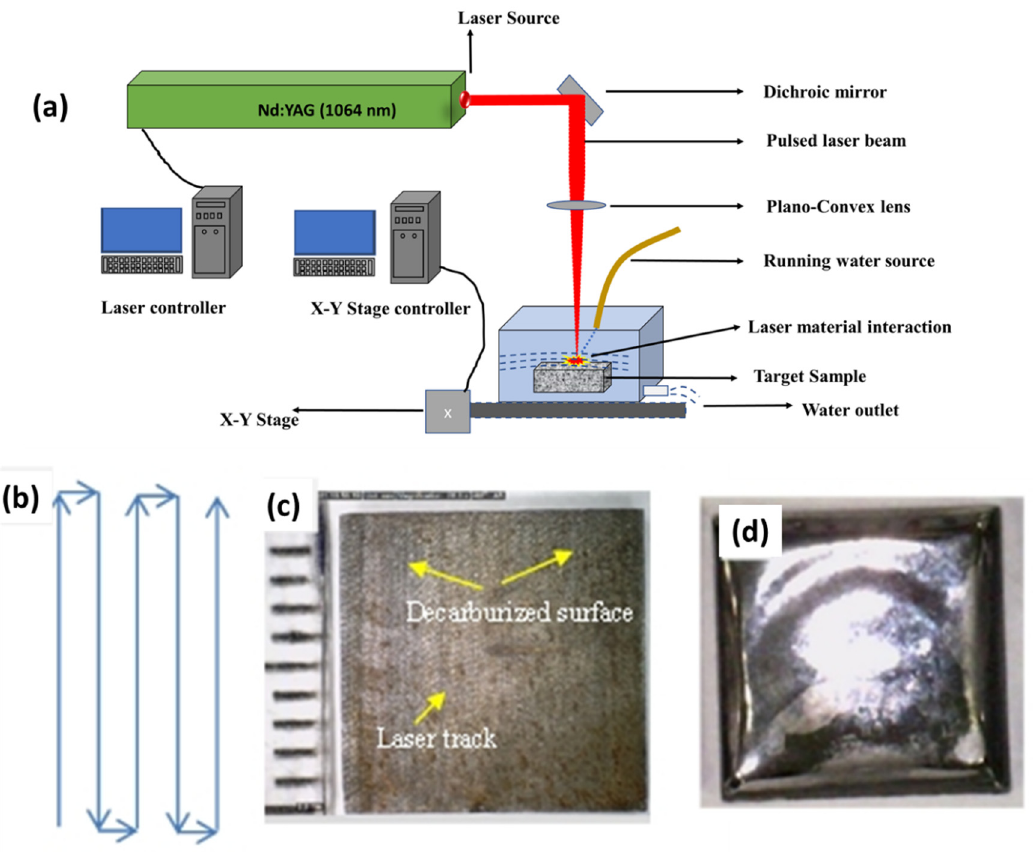
Figure 1. ( a ) Schematic of a laser shock peening setup. ( b ) Schematic representation of bidirectional laser peening strategy. ( c ) LSPwC sample with laser tracks and decarburized surface. ( d ) Sample after electropolishing.